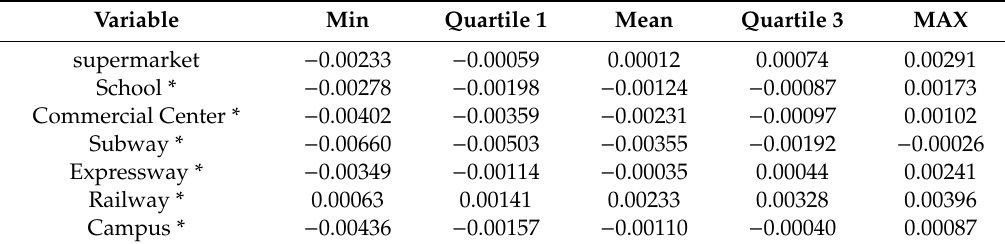
Table 5. Regression coe ffi cient local variable statistics.